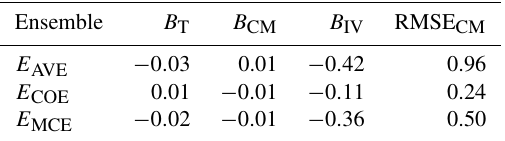
Table 6. Model-as-truth performance comparison of different meth- ods on NARCLiM data, median of trend bias ( B T ), climatological monthly bias ( B CM ), interannual variability bias ( B IV ) and clima- tological monthly RMSE (RMSE CM ) on validation data.